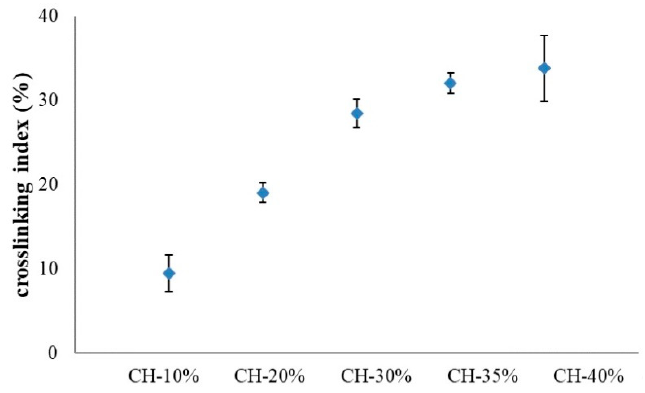
Figure 3. Crosslinking index of CH hydrogels made from oxidized HA/collagen at different concentrations ( w / w ). Error bars represent standard deviations of triplicate measurements.